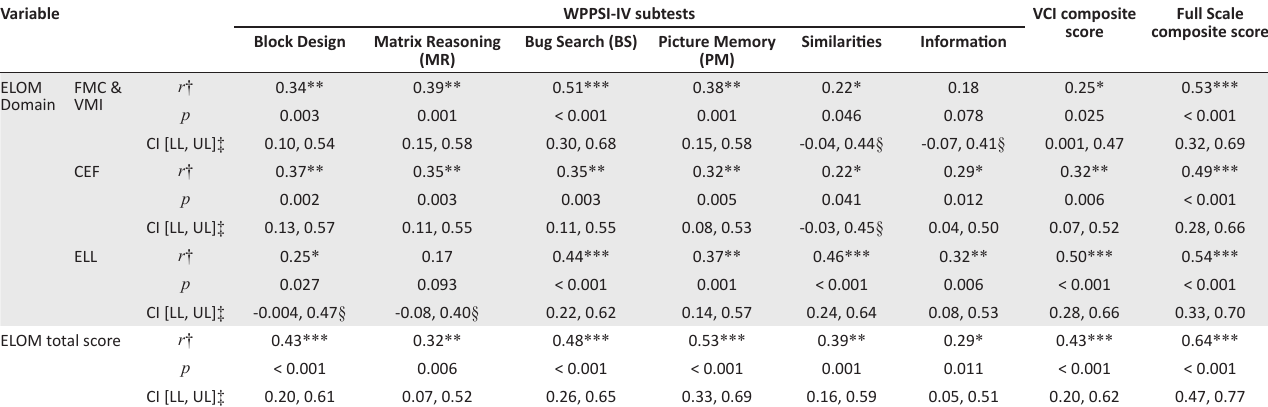
TABLE 7: Correlations of Early Learning Outcomes Measure domains and WPPSI-IV subtests. Variable